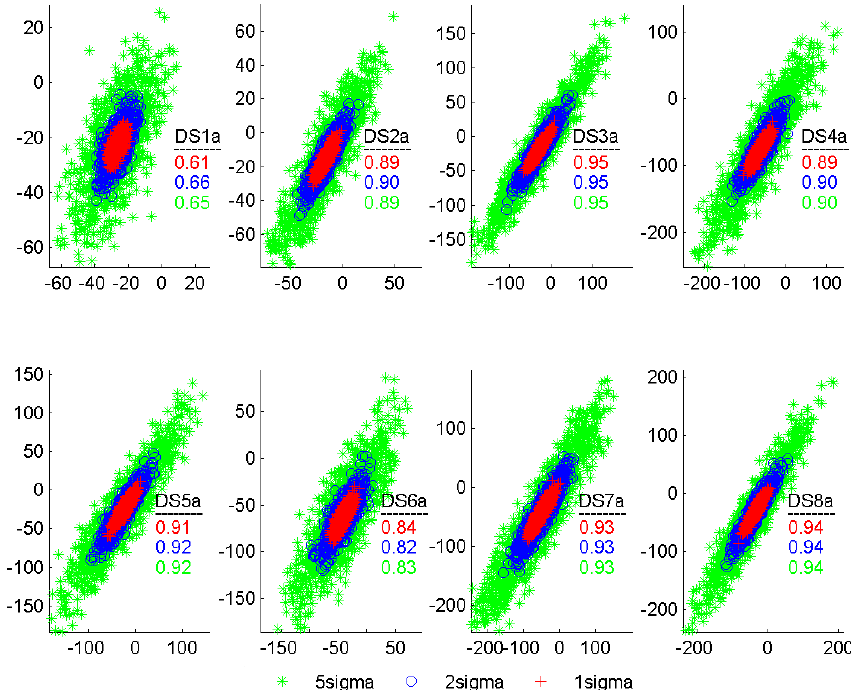
Figure 4. Correlation between the linear trend in the simulations x (cid:48) ( y axis) and the corresponding approximation ˆ x (cid:48) ( x axis). The units are Gtyr − 1 . The colors are associated with the changing range of x (cid:48) for a standard deviation going from 1 σ to 5 σ . The numbers refer to the R 2 coefficients of the error bounds of the corresponding